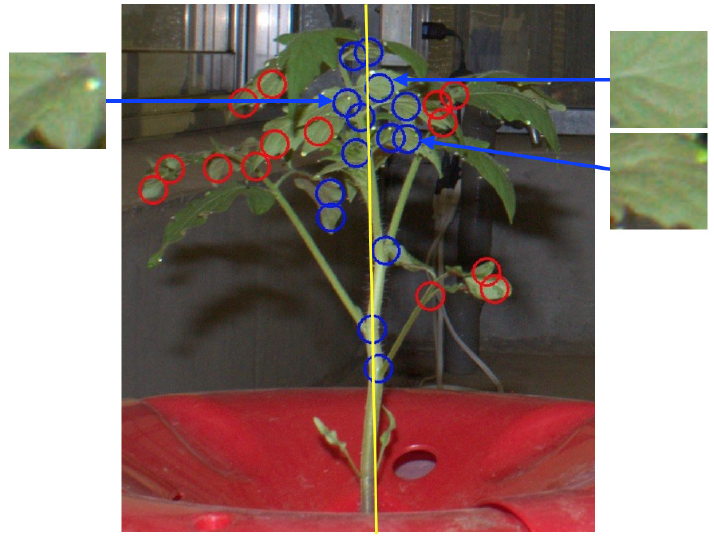
Figure 5. False positives occurring on a leaf. The circles represent the candidate pixels of the node after applying main stem detection (blue: remaining candidate, red: removed candidate). The yellow line represents the main stem line. Table 3. Recall and precision of node detection with and without false positive elimination (Original: without any false positive elimination, MS: false positive elimination based on main stem detection described in Section 2.2.3, MS + BoVWs: both false positive eliminations based on main stem detection and BoVWs described in Sections 2.2.3 and